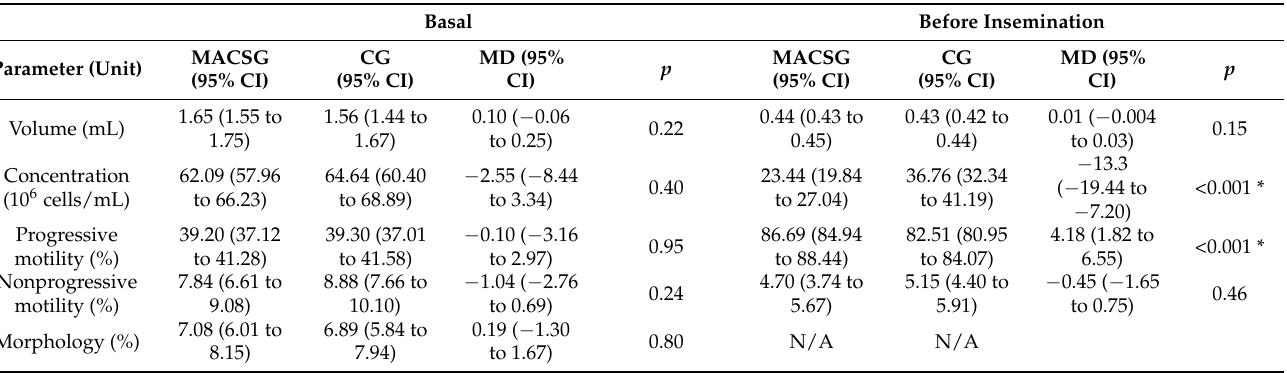
Table 1. Seminal parameters. Characteristics of the seminal samples and sperm functions obtained after ejaculation and before insemination in MACSG and CG.